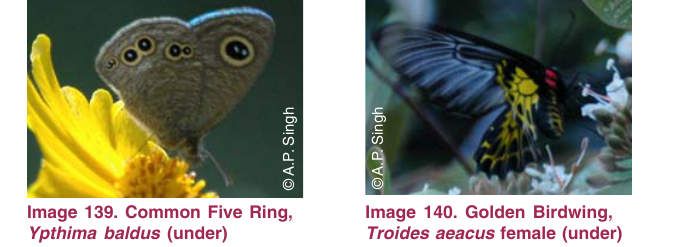
Image 141. Himalayan Five Ring, Ypthima nikaea (under)